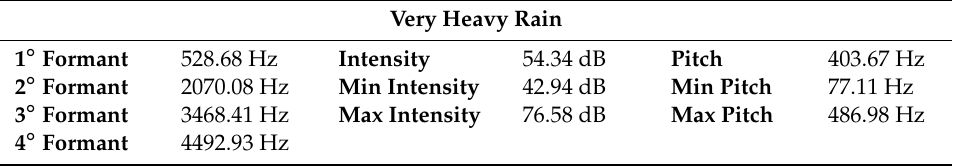
Table 5 outlines the obtained values: Table 5. Formants, intensity and pitch parameters of “Very heavy rain” audio signal.